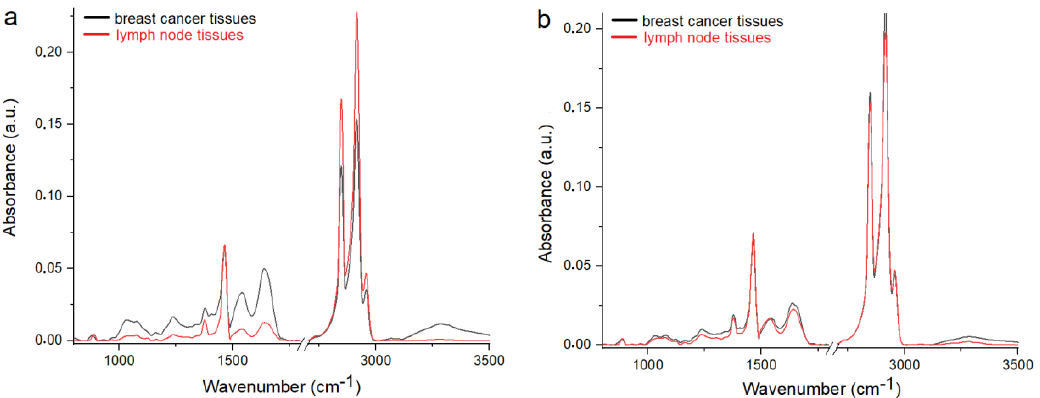
Figure 3. Average FTIR spectra of the breast cancer tissues and LNs from the ( a ) I and ( b ) II groups. The description of peaks’ characteristics for the Raman and FTIR spectra of the breast cancer tissues and LNs are presented in Table